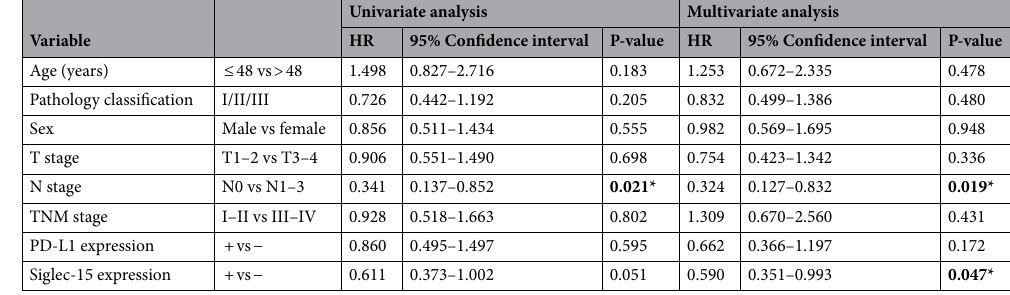
Table 5. Univariate and multivariate Cox proportional hazard analyses of clinicopathologic variables for the D-FFS rate. Siglec-15 Sialic acid-binding immunoglobulin-like lectin 15, PD-L1 programmed cell death-Ligand 1, WHO World Health Organization, D-FFS distant failure-free survival. Significant values are in bold.